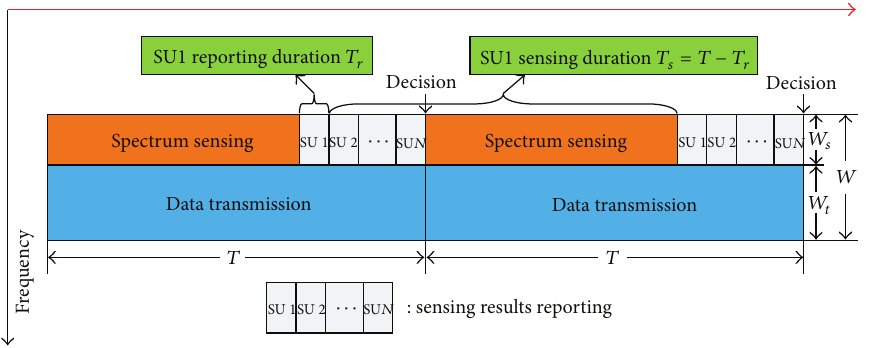
Figure 1: New frame structure for